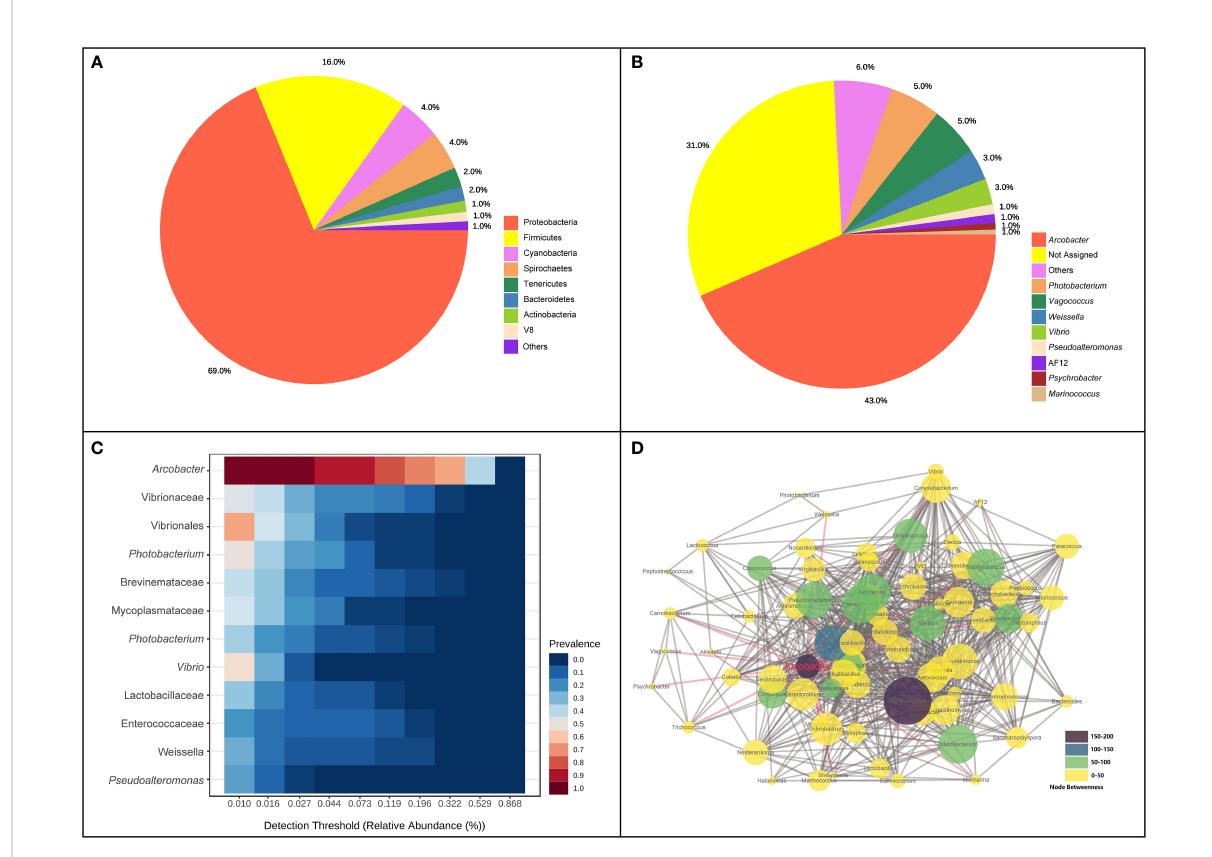
FIGURE 1 Composition and co-occurrence of intestinal bacterial community of puffer fi sh using all samples in this study. (A) The proportion of intestinal bacterial abundance at phylum level; (B) The proportion of intestinal bacterial abundance at genus level; (C) Core bacterial taxa in the intestinal bacterial community; (D) Microbial co-occurrence networks at the genus